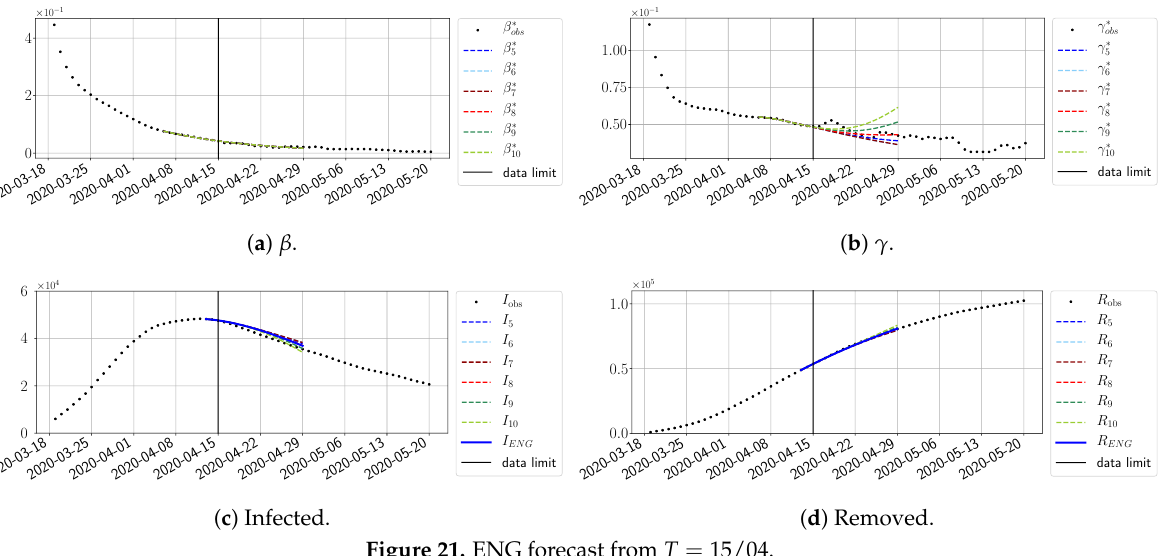
Figure 21. ENG forecast from T = 15/04.